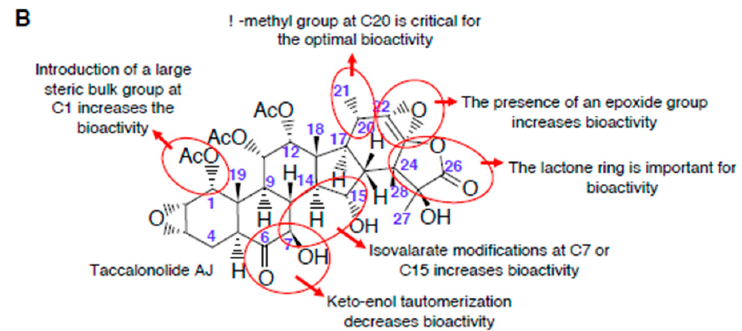
Figure 2. A ) Chemical structures of taccalonolides. B ) Structure-activity relationships of